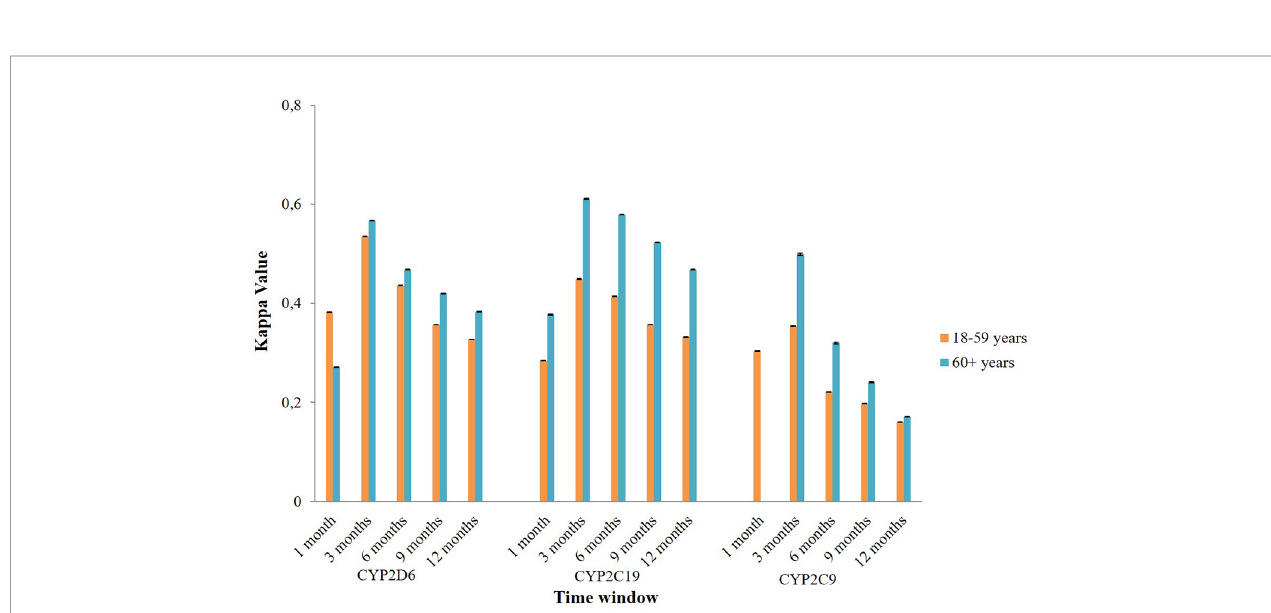
FIGURE 5 | The effect of age on the agreement between the Lifelines cohort and the IADB.nl